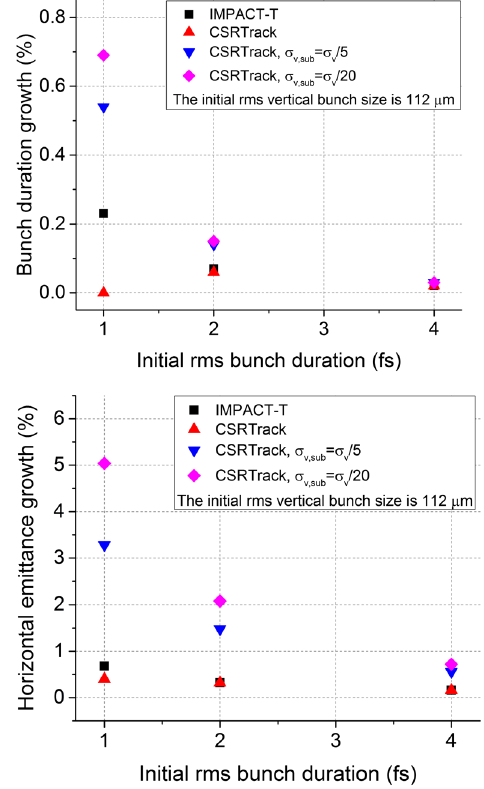
m.FIG. 2. IMPACT - T and CSRT rack simulation results of the bunch duration and emittance growth of a 100-MeV, 5-pC bunch for different initial bunch durations after drifting after a 0.1 m long horizontal and vertical bunch size are 0 . 25 μ m, 0.2%, 112 μ m and 112 μ m respectively. 50,000 macroparticles were used.